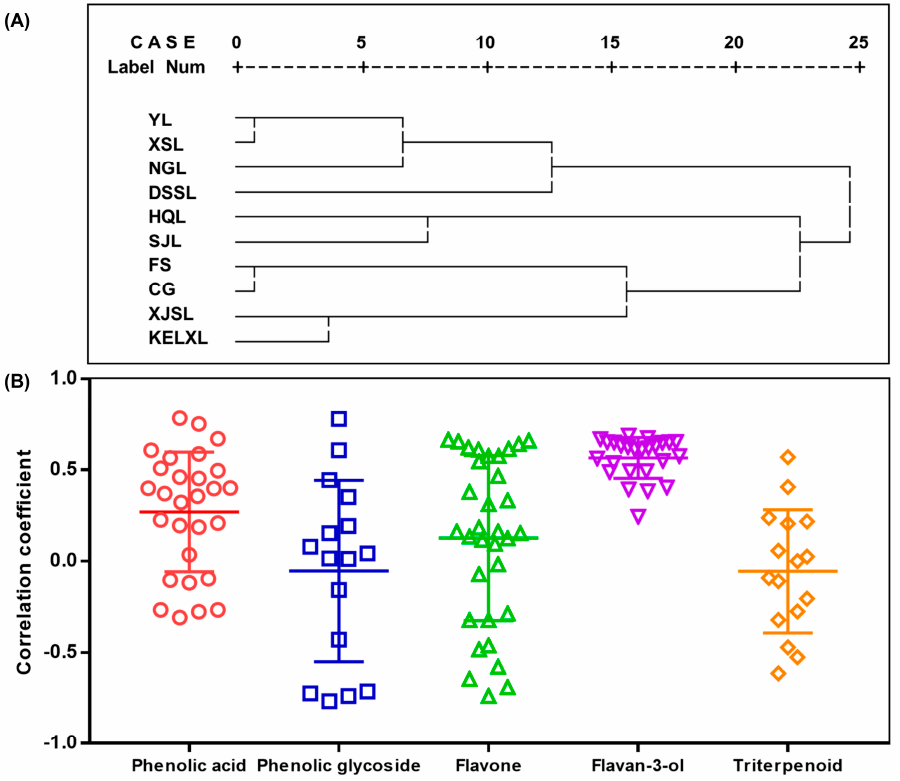
Figure 3. Hierarchical clustering analysis of pear samples ( A ) and the spectrum–effect relationship between total antioxidant activity and individual chemical compound ( B ).